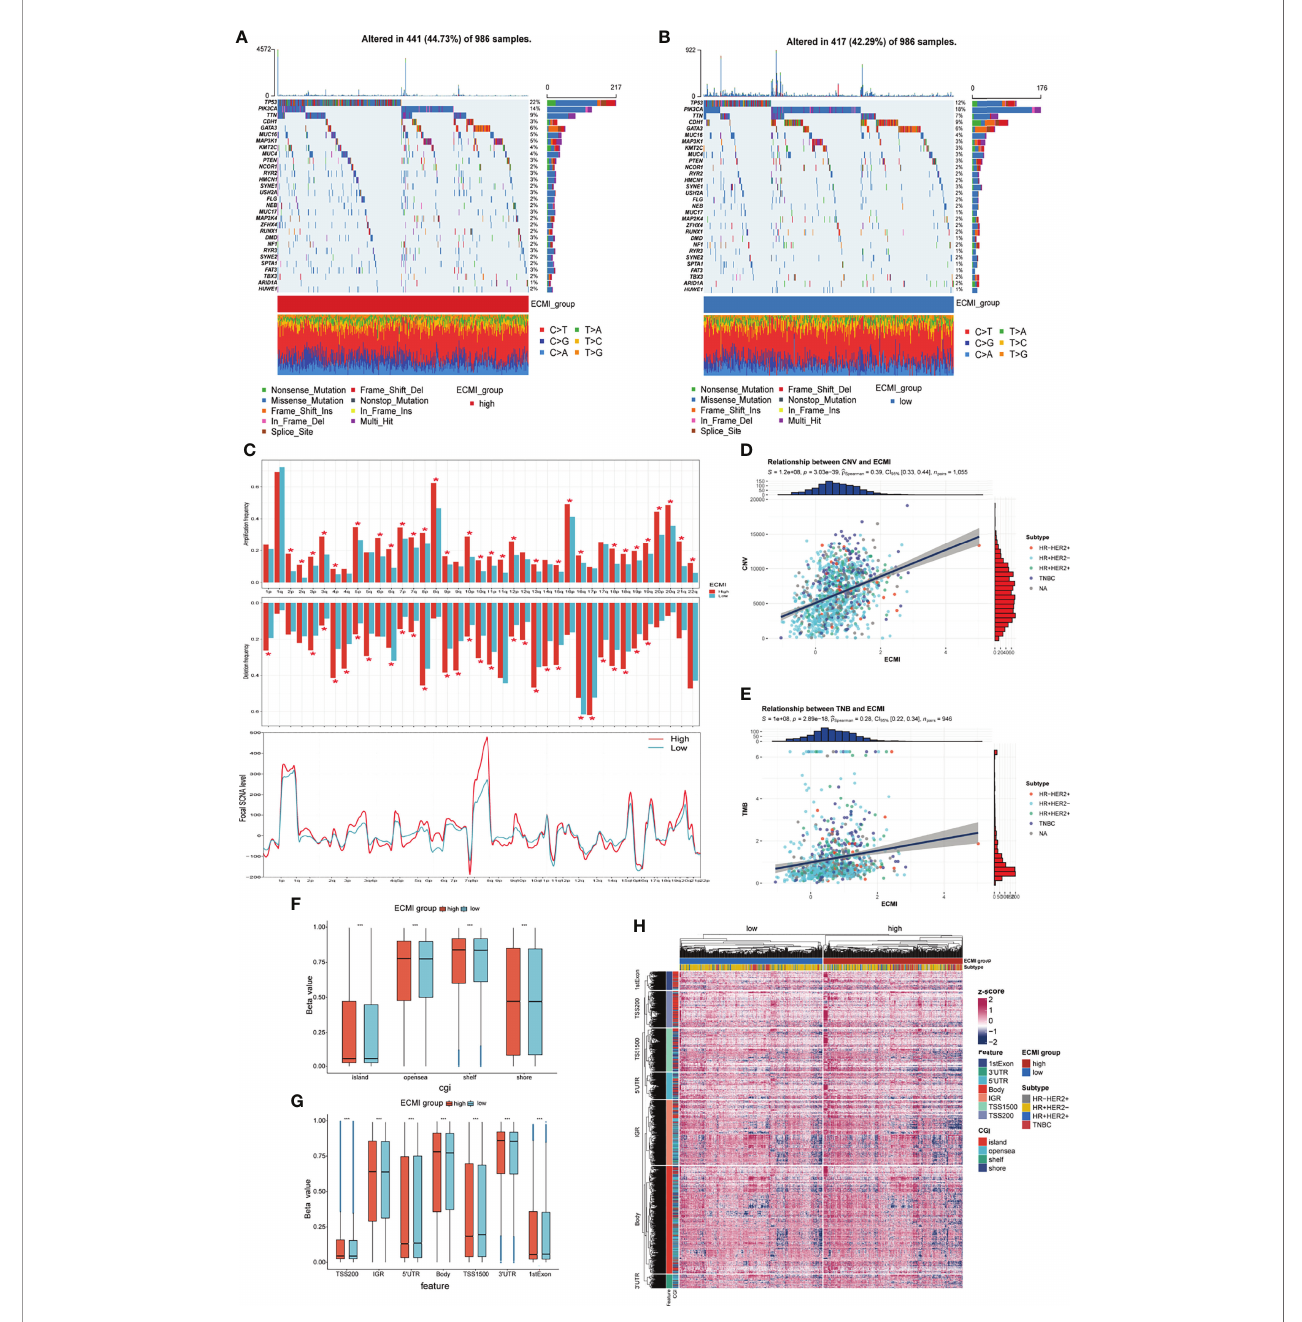
FIGURE 6 | Genomic features of the ECMI high and low groups. (A, B) List of the most frequently mutated genes in ECMI high and low groups. (C) Global distribution of gain- or loss-of-function mutation in the 22 human chromosomes in the two groups. Ampli fi cation of genes is marked in red. Deletion of genes is marked in turquoise. The above diagram represents the arm-level CNV, and the bottom represents the focal-level CNV. (D, E) Correlation between the ECMI and total CNV or TMB in TCGA. (F, G) Methylation difference between the ECMI high and low groups in different CGI coordinates and feature types. (H) Heatmap exhibiting the DNA methylation pattern of the ECMI high and ECMI low groups. The location of each DNA methylation site is annotated on the left. The IHC subtype is shown in the top